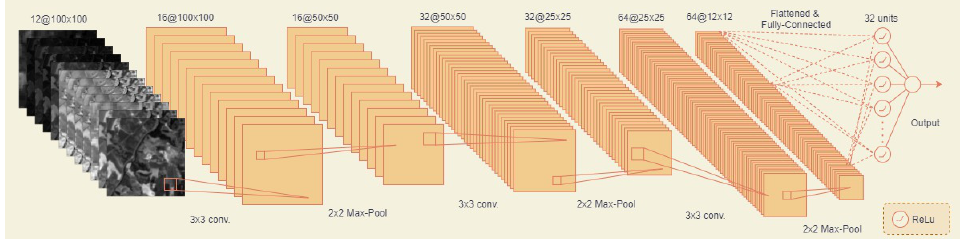
Figure 4. Initial experiment 1: single image CNN model